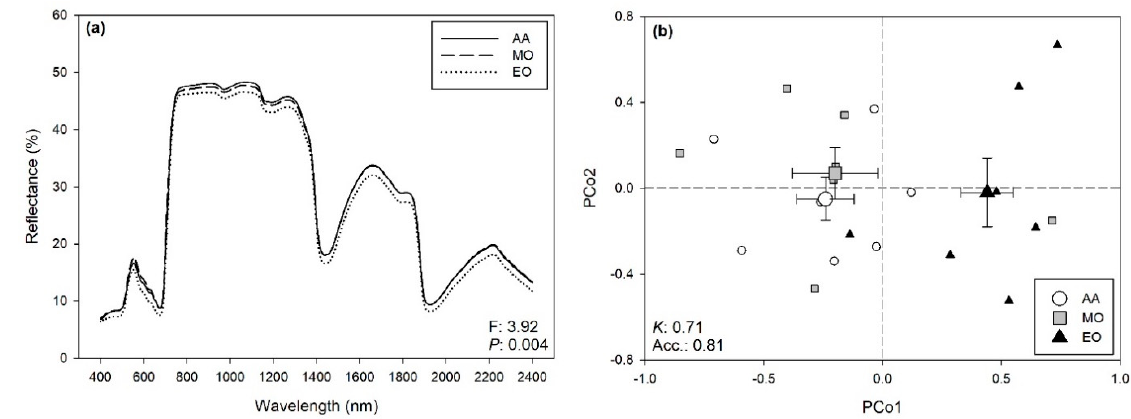
Figure 3. ( a ) Average foliar reflectance profiles of date palms exposed to ambient air (AA), moderate ozone (MO), and elevated ozone (EO); F- and P -values from permutational analysis of variance (PERMANOVA) for the effects of ozone on the full range (400–2400 nm) reflectance profiles of date palm leaves are reported in the bottom-right corner of the panel. ( b ) Scores (mean ± standard error) for the first and second principal components from principal coordinates analysis (PCoA) of the reflectance data (400–2400 nm) collected from date palm leaves, highlighting the capability of spectroscopy to discriminate plants exposed to AA (white circle) vs. plants exposed to MO (gray square) and EO (black triangle); average accuracy (Acc.) and Kappa ( K ) values from partial least squares discriminant analysis (PLS-DA) are reported on the bottom-left corner of the